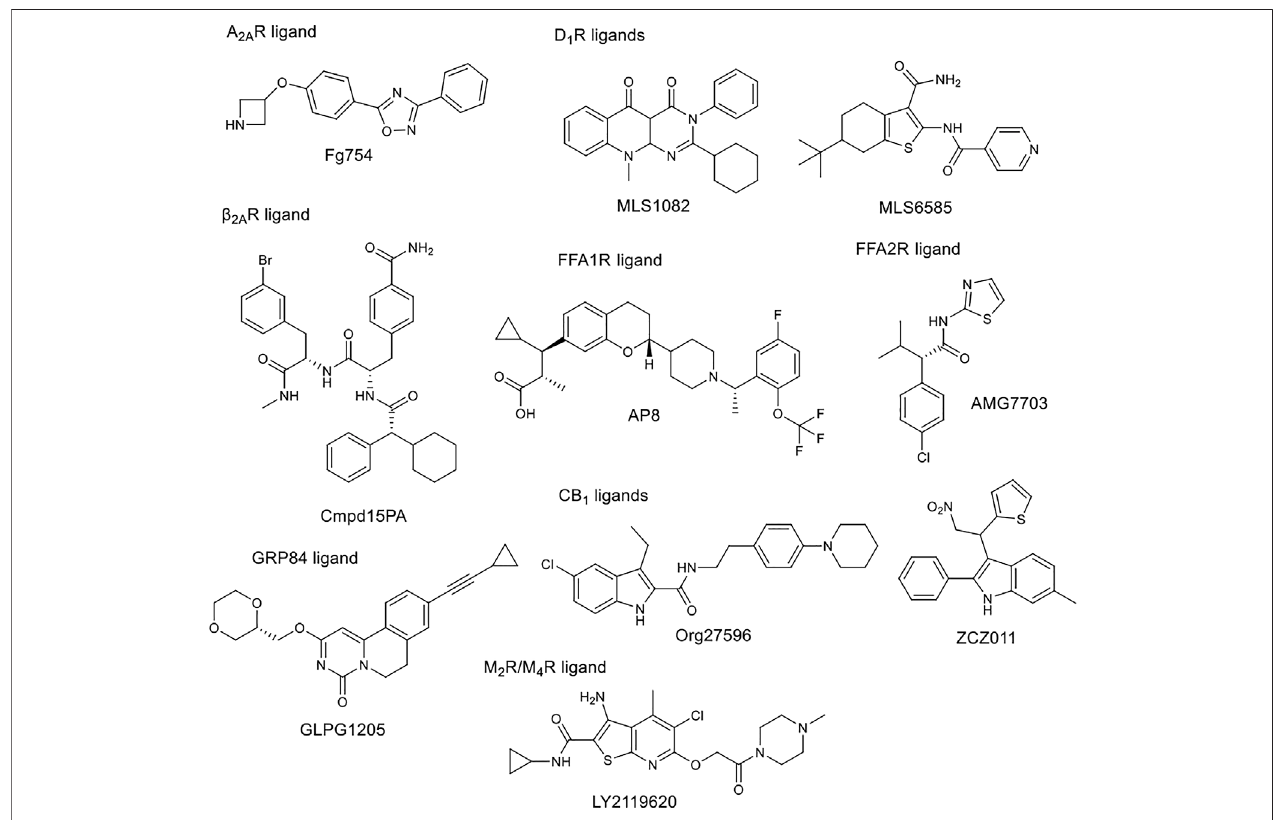
FIGURE 4 | Chemical structure of selected allosteric